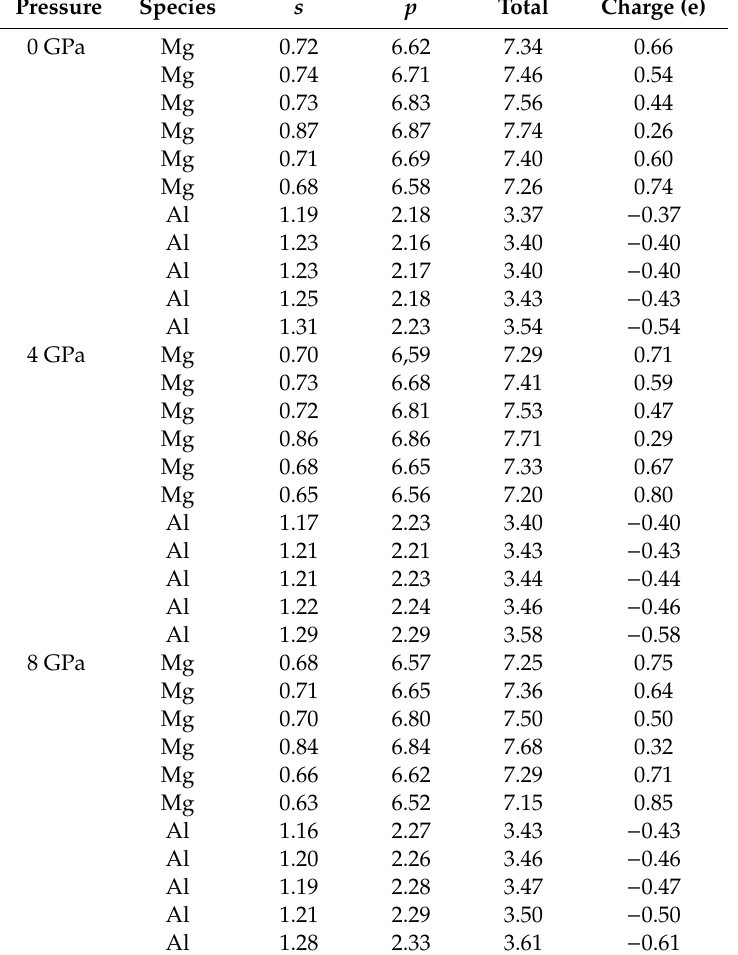
Table 2. Mulliken population analysis of Mg 23 Al 30 at 0 GPa, 4 GPa and 8 GPa.